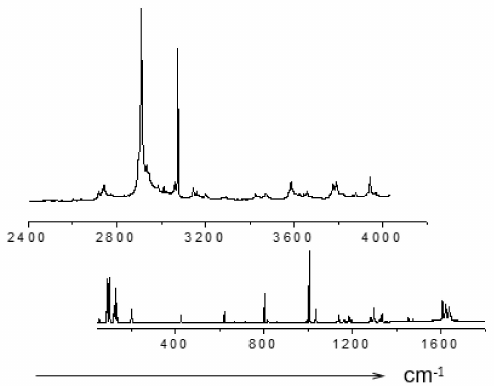
Figure 14. A comparison of the high-wavenumber (2400–4000 cm − 1 , top) and intramolecular (50– 1700 cm − 1 , bottom) vibrations at T = 10